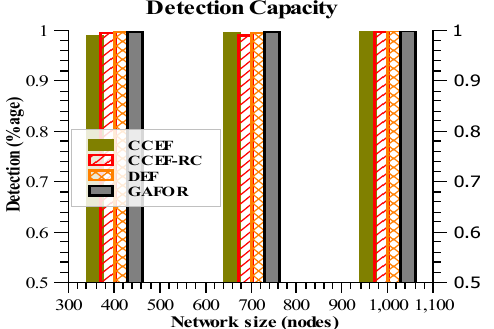
Figure 13. Detection